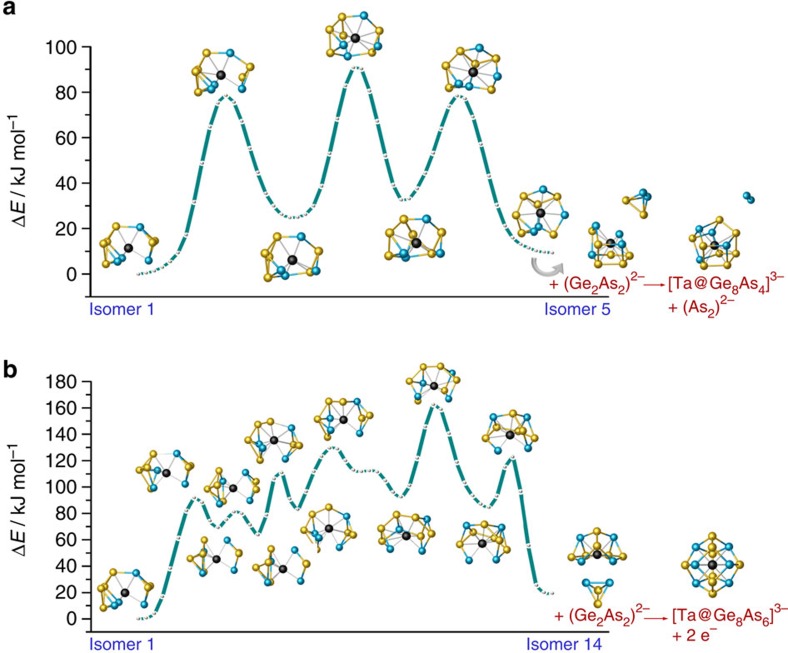
Stepwise re-arrangements of the most stable anion isomer in 3.(a) Re-arrangement into isomer 5. (b) Rearrangement into isomer 14. The final topologies are suitable for uptake of another (Ge2As2)2− unit from 1 to form the clusters [Ta@Ge8As4]3− (top) or [Ta@Ge8As6]3− (bottom) in 4. Detailed explanations are given in the text.